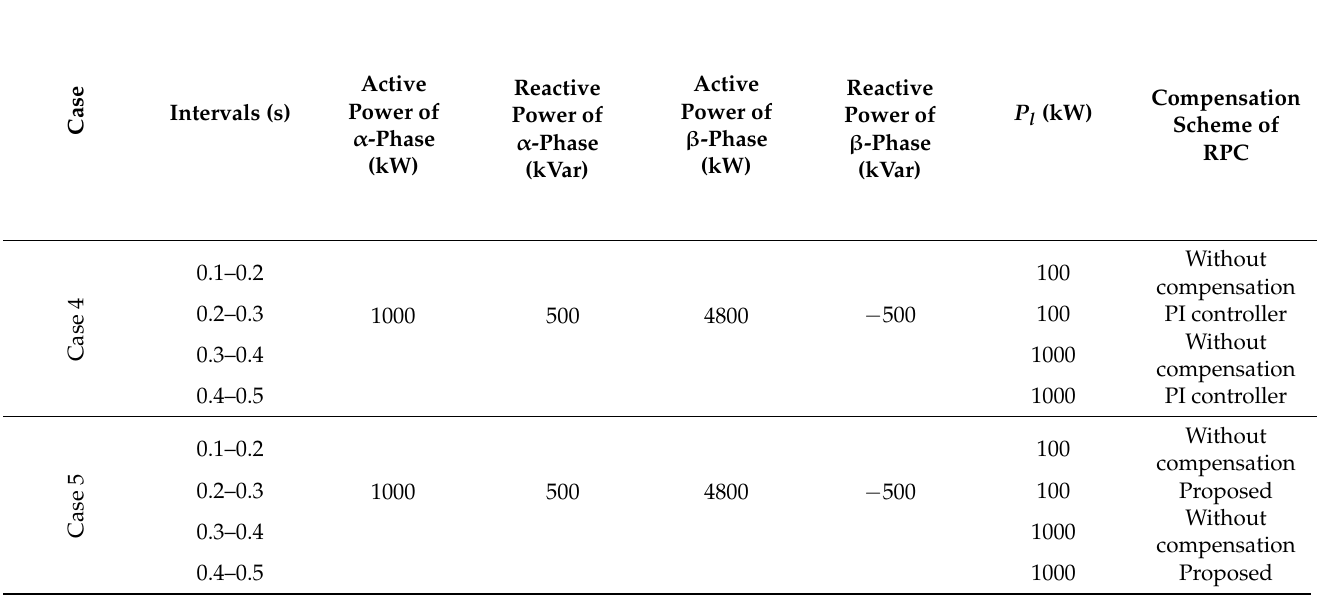
Table 6. Simulation parameters of Case 4 and Case